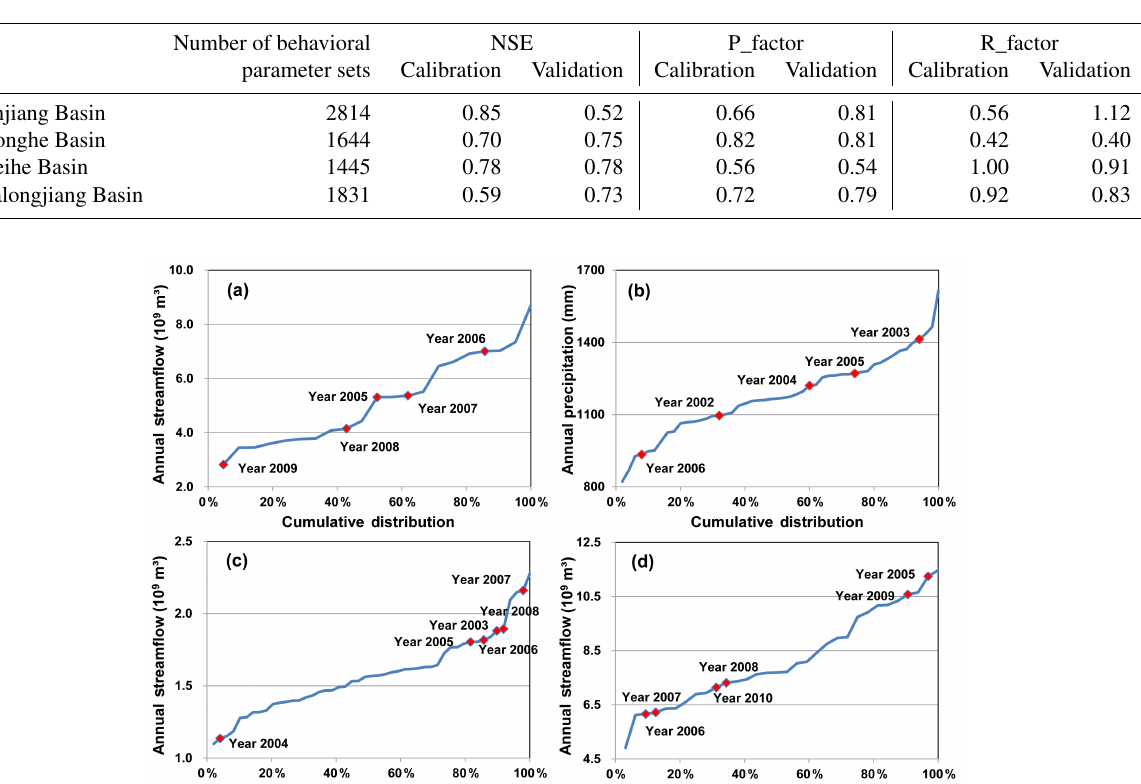
Figure 7. (a) Cumulative distribution of annual streamflow in the Jinjiang Basin (at the Shilong station) for the period of 1958 to 2009. (b) Cumulative distribution of annual precipitation in the Donghe Basin for the period of 1961 to 2010. (c) Cumulative distribution of annual streamflow in the Heihe Basin (at the Yingluoxia station) for the period of 1960 to 2008. (d) Cumulative distribution of annual streamflow in the Yalongjiang Basin (at the Ganzi station) for the period of 1980 to 2011.